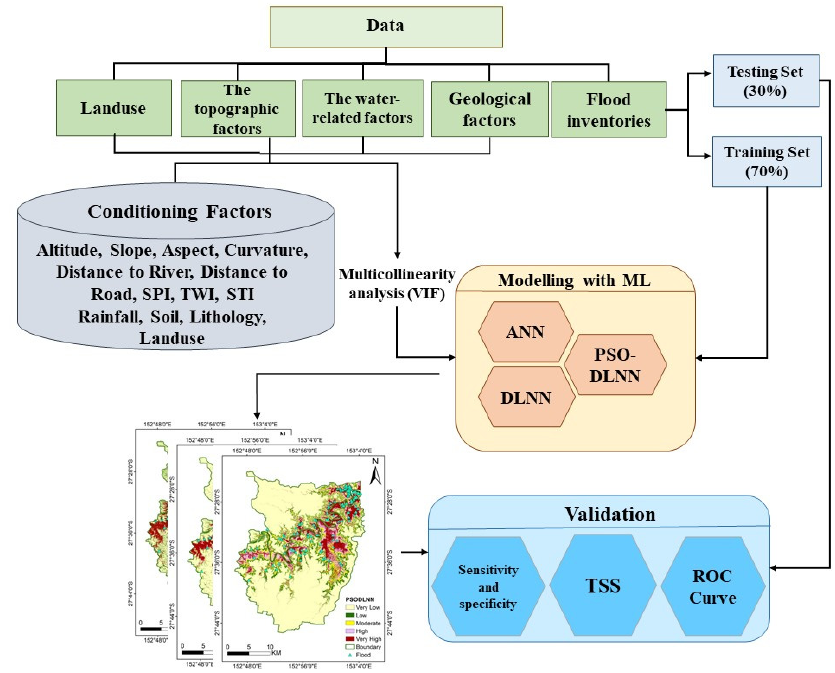
Figure 3. Procedures for flood susceptibility mapping in this study.